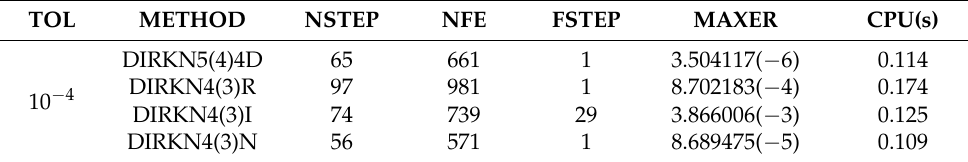
Table 4. Data for Example